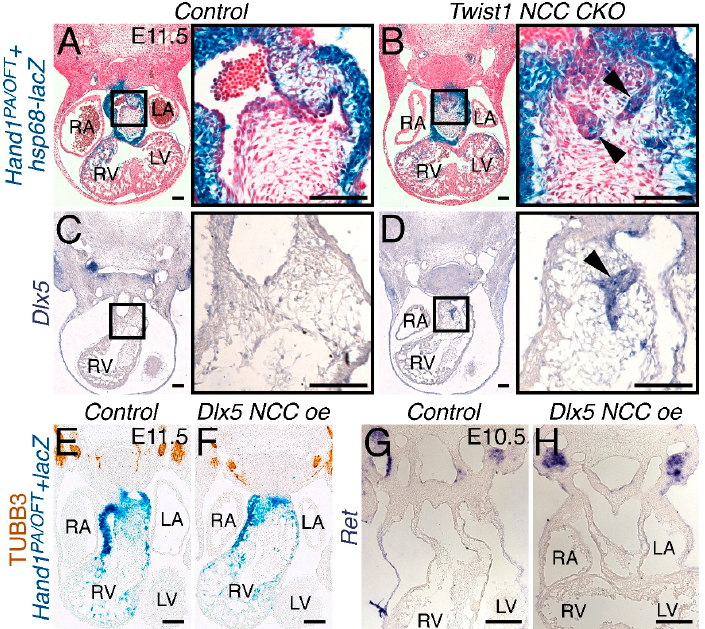
Figure 7. Ectopic Dlx5 expression within the NCC is not sufficient to induce neurogenesis. ( A, B ) E11.5 Hand1 PA/OFT - lacZ stained control ( A ) and Wnt1-Cre(+); Twist1 – /fx mutant ( B ) embryos showing transgene-positive ectopic ganglia within the cardiac NCCs occupying the OFT. ( C , D ) In situ hybridization to detect Dlx5 mRNA shows no expression in control OFTs (C) but does show robust expression within the trans-differentiated cardiac NCCs of Twist1 conditional knockouts (D). Immunohistochemistry of pan-neuronal TUBB3 in both control ( E ) and Dlx5 NCC oe ( F ) sections reveals no ectopic neuronal staining in the E11.5 OFT. In situ hybridization to detect Ret mRNA similarly reveals no neuronal cells within the OFTs of E10.5 control ( G ) or Dlx5 NCC oe ( H ) embryos. Scale bars = 100 µm .